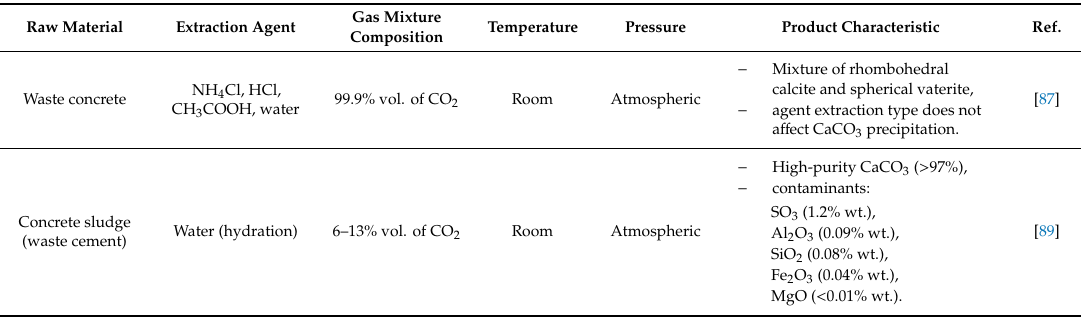
Table 4. Process parameters of CaCO 3 precipitation technologies for concrete and cement waste utilization using carbonation